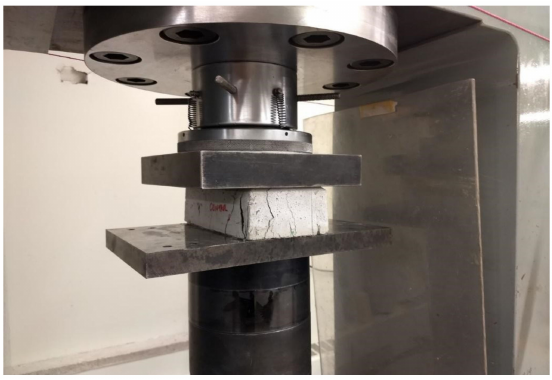
Figure 4. Compression test in the MTS ® compression